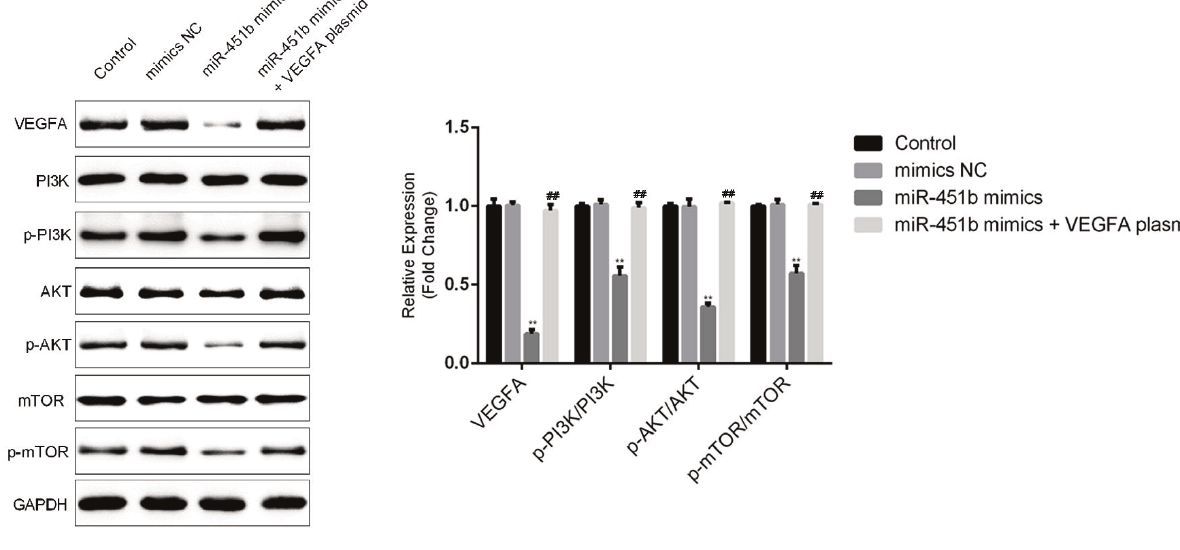
Figure 4: miR-451b mimics inhibit the PI3K-Akt-mTOR pathway in HUVECs. After cell transfection, western blot analysis was used to detect the protein expression levels of VEGFA, PI3K, p-PI3K, AKT, p-AKT, mTOR, and p-mTOR in HUVECs. The protein levels were quantified. **p<0.01 vs. mimics NC; ##p<0.01 vs. miR-451b